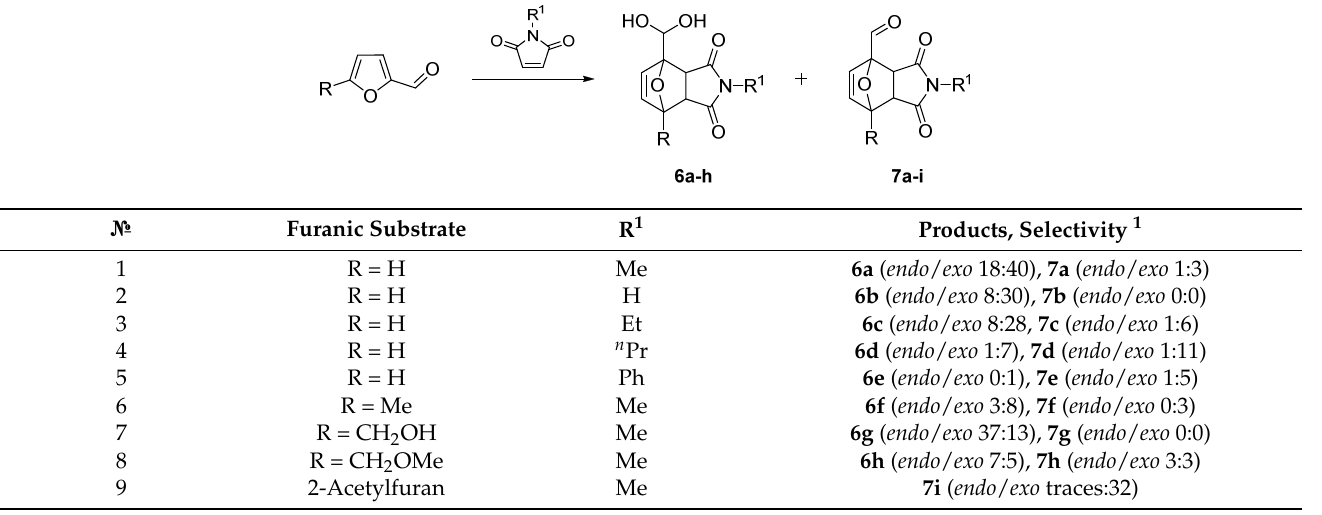
Table 7. Direct DA reaction of furanic aldehydes with maleimides in water medium.